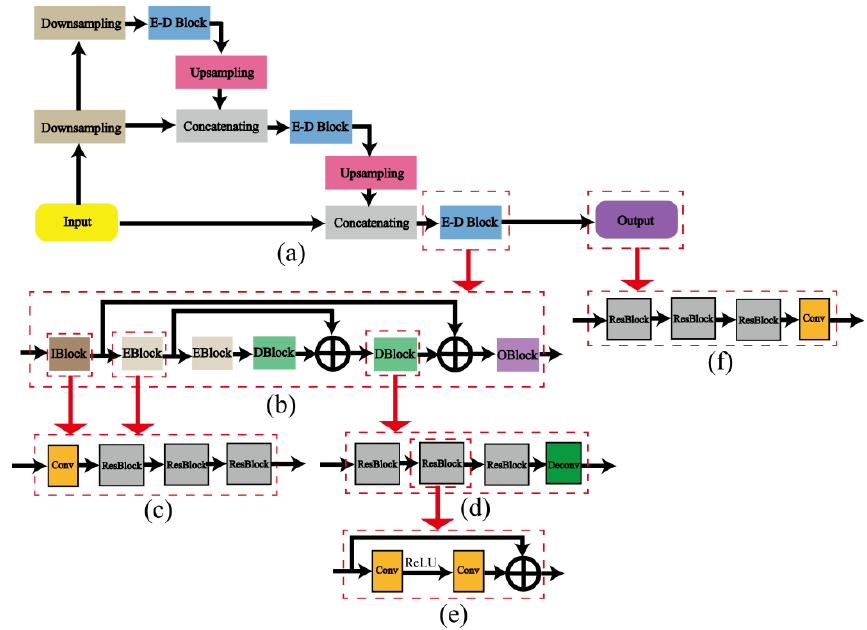
Figure 3. Architecture of the convolutional neural network in the proposed method. ( a ) Overall structure; ( b ) architecture of Encoder-Decoder block (E-D block); ( c ) architecture of Encoder Residual block (Eblock) or Input Residual block (Iblock); ( d ) architecture of Decoder Residual block (Dblock); ( e ) architecture of Residual block (Resblock); ( f ) output Residual block (Oblock).